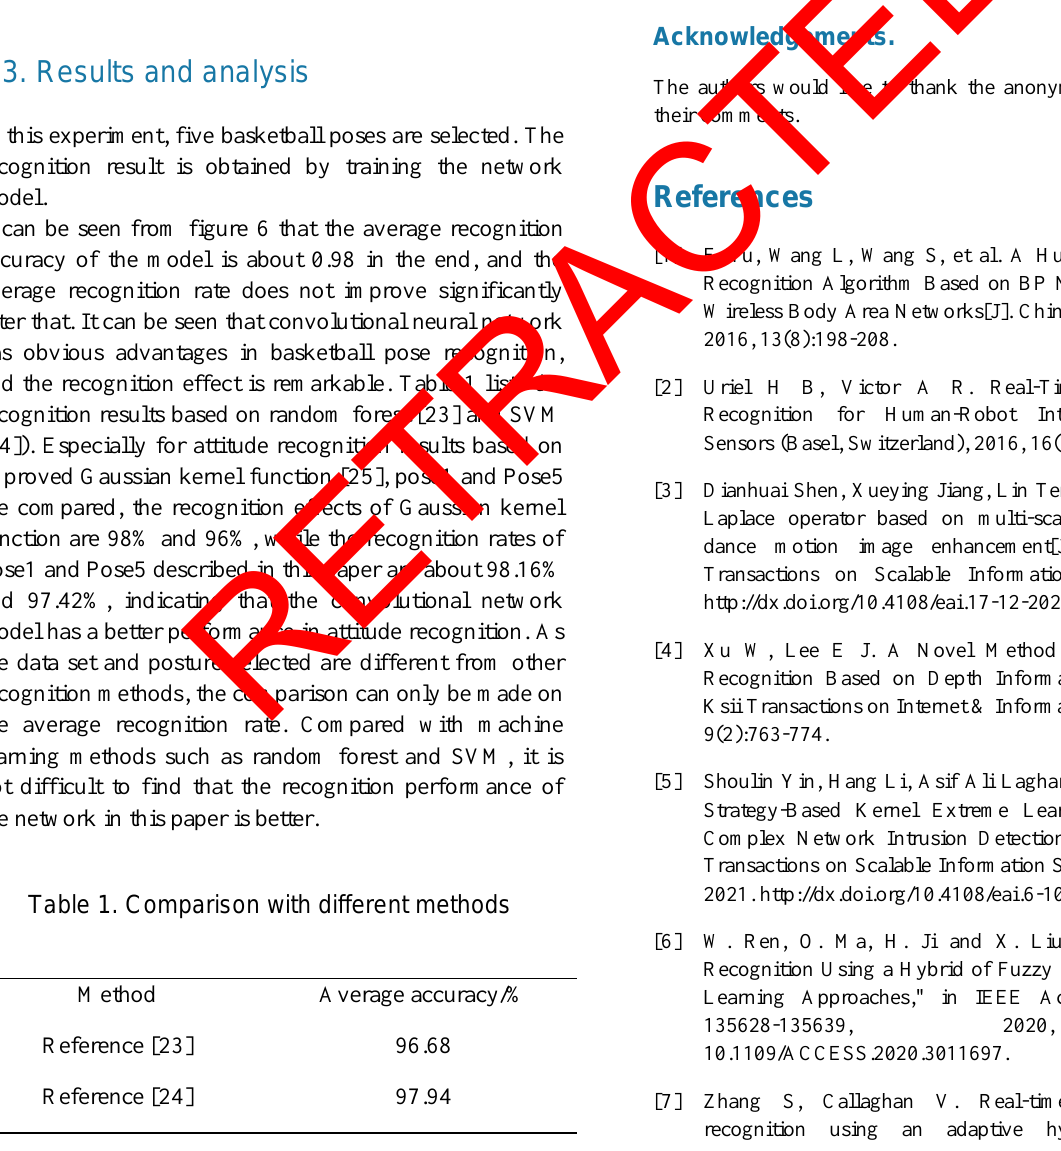
Figure 6. The validation accuracy changes with the number of iterations (VA denotes validation accuracy)